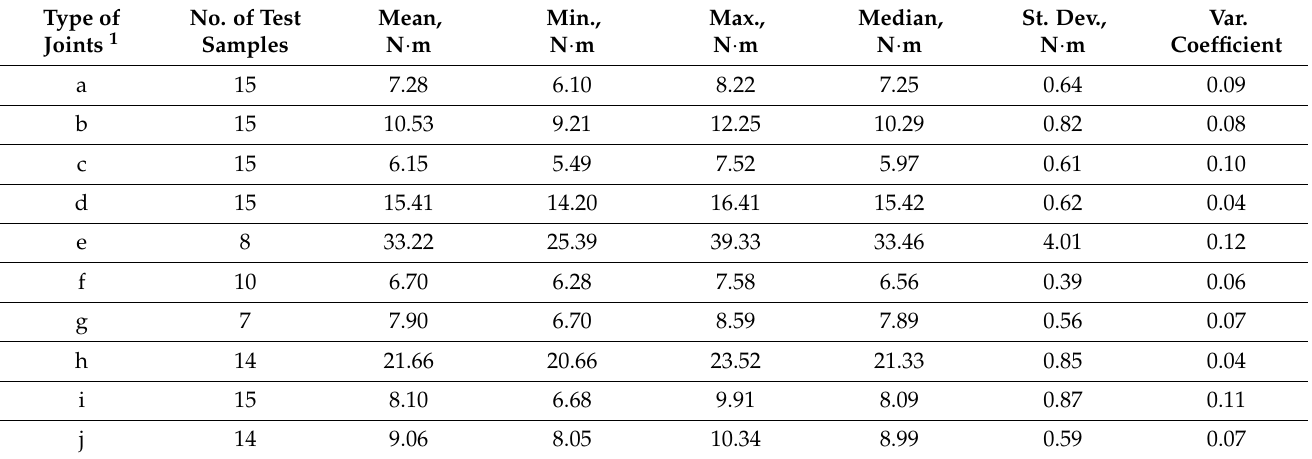
Table 2. Bending moments of corner joints made of lightweight